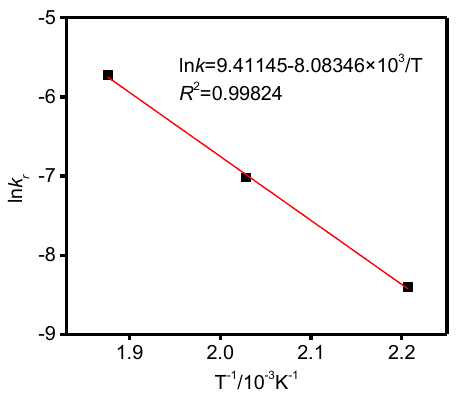
Figure 11: Arrhenius plot between ln kr and 1/ T for the calculation of activation energy. The values of K r were calculated by using the bagdasarrym model